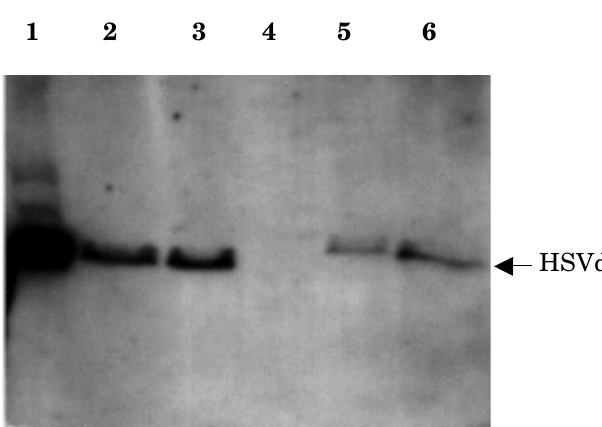
Fig. 2. Northern-blot analysis of some of the samples that gave a hybridisation signal in Fig. 1. After sequen- tial polyacrylamide gel electrophoresis (sPAGE), the gel was electrotransferred to a nylon membrane and hybrid- ised against a HSVd-specific riboprobe (see Materials and methods section for details). Lane 1, positive con- trol consisting of HSVd-infected Japanese plum cv. Tai- yo; lanes 2, 3 and 6, apricot samples from Morocco; lane 5, apricot sample from Turkey; lane 4, uninfected nega- tive